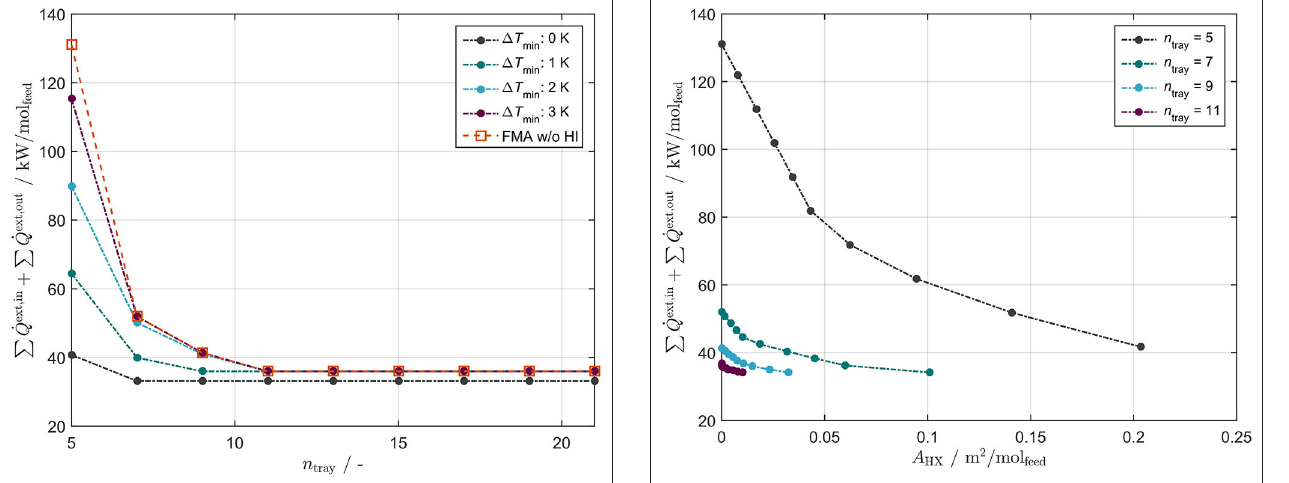
FIGURE 11 | Pareto curve of the two competing objectives illustrating the trade-off between minimization of total energy duty and minimization of additional heat transfer area for different number of separation stages: 5, 7, 9, and 11